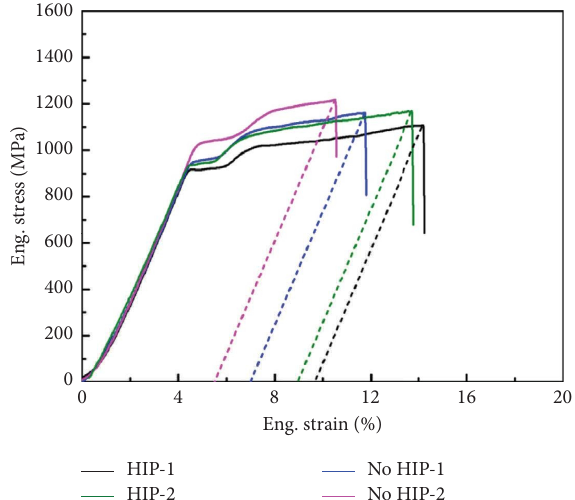
Figure 15: Engineering stress/strain curves of samples without and with HIP at 760 ° C